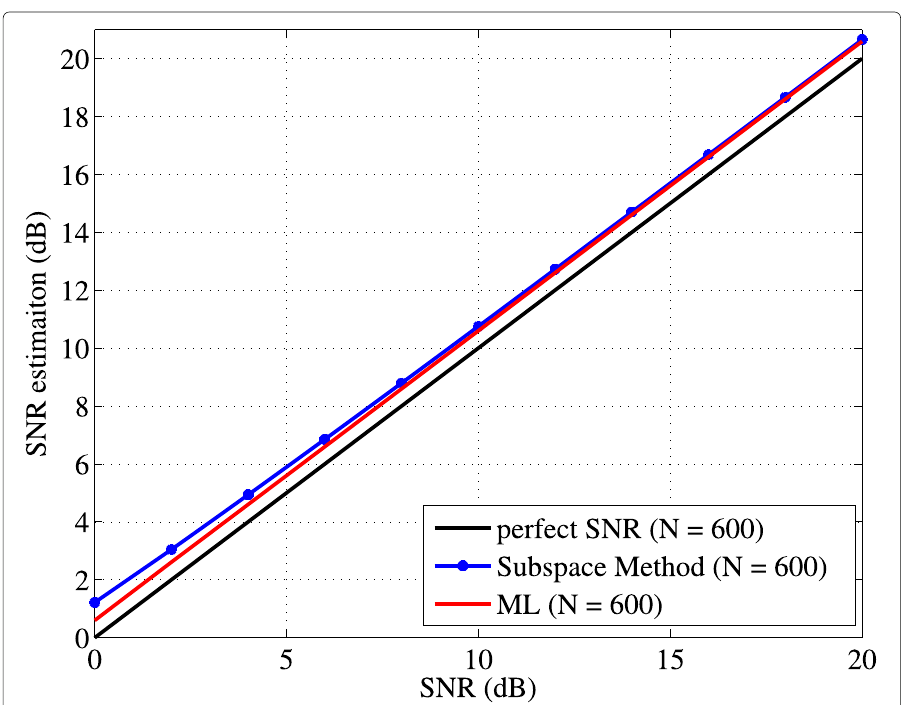
Fig. 5 The difference comparison among the subspace method-based SNR, ML-based SNR, and perfect SNR under N = 600. Perfect SNR ( N = 600), subspace-based method ( N = 600), and ML-based method ( N =